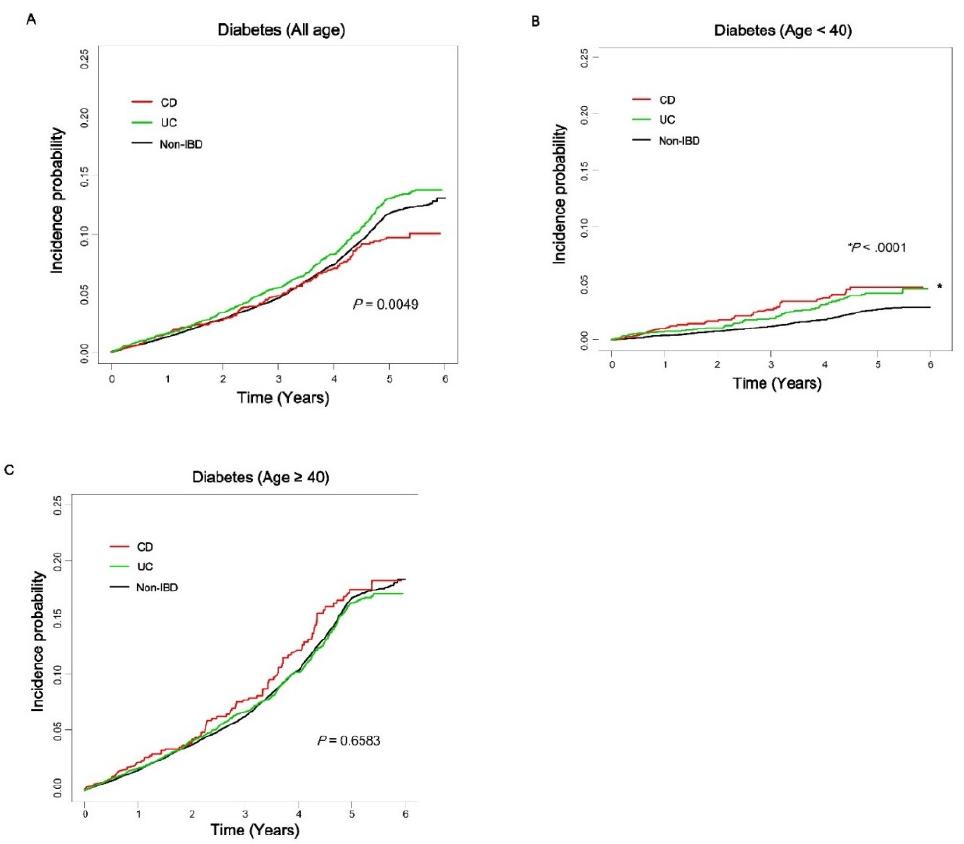
Figure 1. Incidence probability of diabetes in patients with Crohn’s disease (CD) and ulcerative colitis (UC) compared with age-matched non-IBD (inflammatory bowel disease) controls based on age group. Patients with CD (red line), UC (green line), and non-IBD controls (black line). All ages ( A ), under 40 years ( B ), over 40 years ( C ). CD, Crohn’s disease; IBD, inflammatory bowel disease; UC, ulcerative